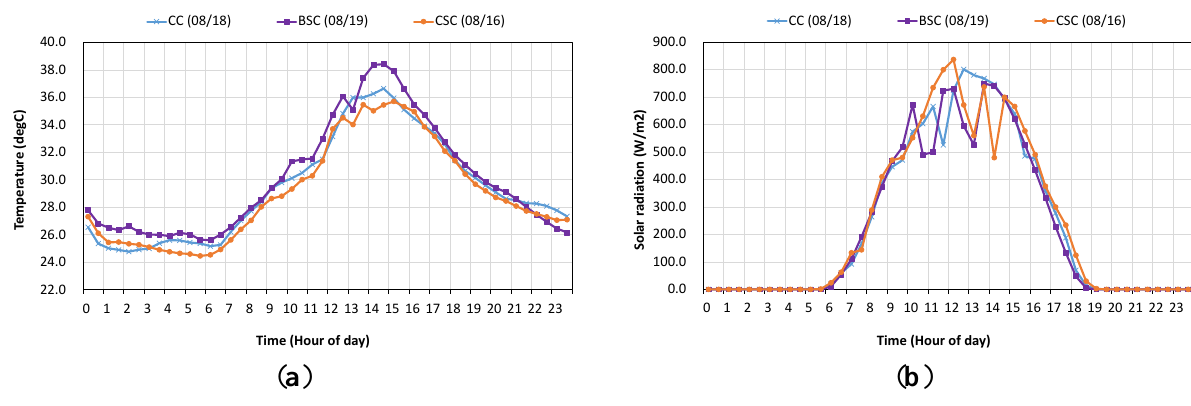
Figure 7. Comparison of weather conditions, ( a ) outdoor temperature and ( b ) global horizontal solar radiation, for three space-cooling operation test days with CC, BSC, and